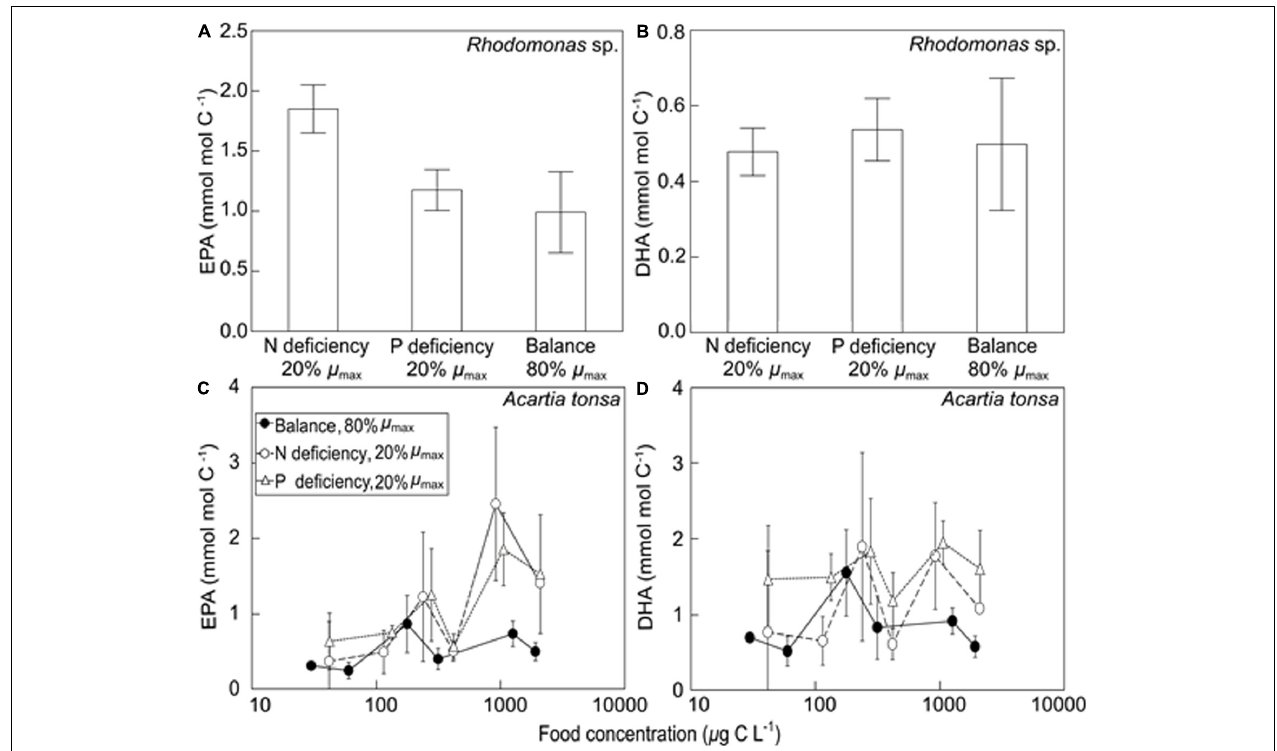
FIGURE 2 | The carbon-normalized contents (mean ± SD) of EPA (eicosapentaenoic acid; 20:5n-3) and DHA (docosahexaenoic acid; 22:6n-3) in Rhodomonas sp. (A,B) under three nutrient treatments (N deficiency and 20% of µ max , P deficiency and 20% of µ max , and the balanced nutrient condition and 80% of µ max ), and in adult A. tonsa (C,D) under different food quantity and quality treatments [N- and P-deficient and slow growing diets (20% of µ max ) and the balanced nutrient and fast growing diet (80% of µ max )]. Data presented in Rhodomonas sp. are mean values of the three experimental runs in each nutrient treatment. Note the log scale is used in (C,D) .